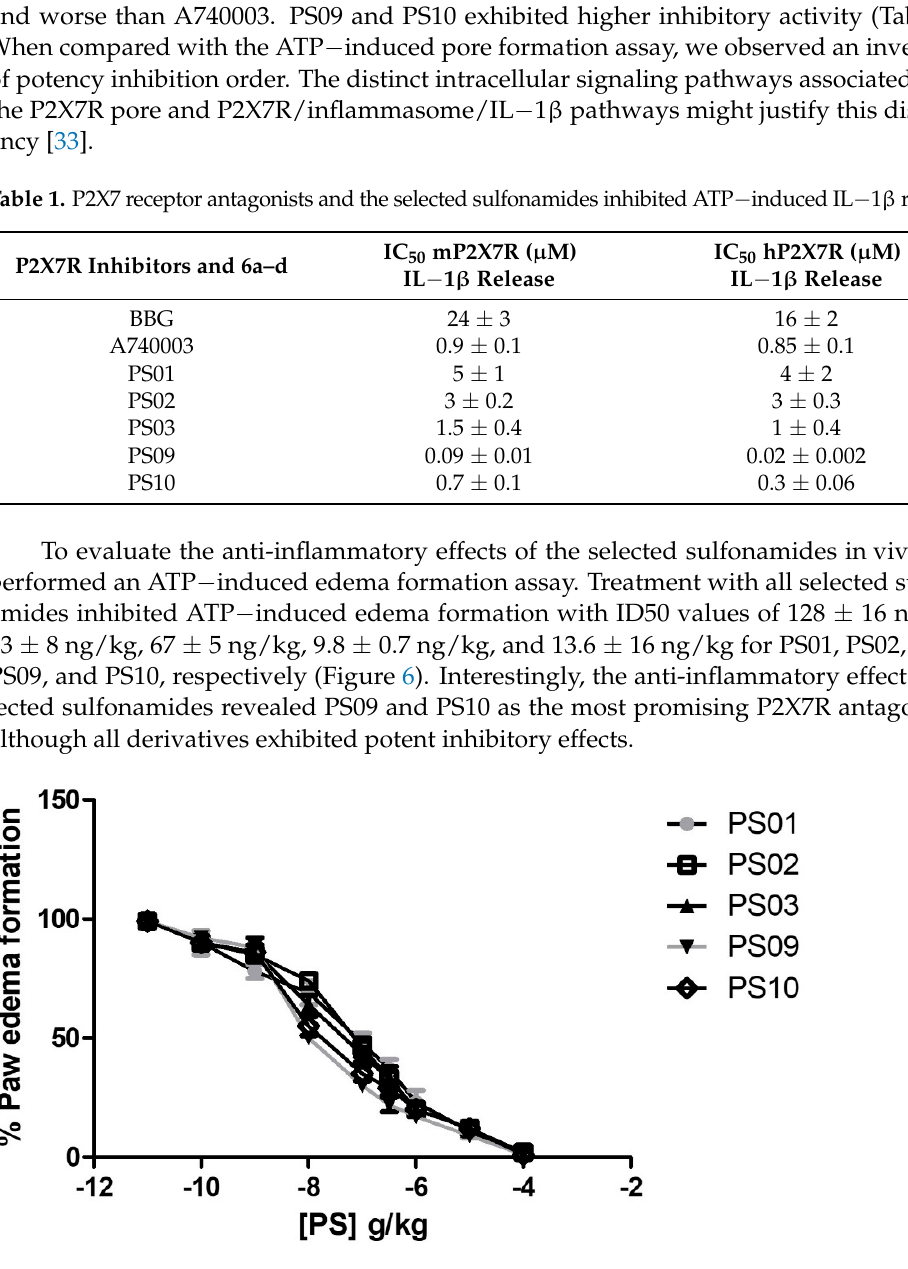
Figure 6. Anti − edematogenic effects of sulfonamides on ATP ‐ induced paw edema in mice. Groups with five Swiss Webster mice treated with ATP (intra ‐ plantar) were preincubated for 30 min with increasing doses of sulfonamides. All sulfonamide data were compared with crescent BBG doses (data not shown). Paw edema was measured at 30 min after ATP application. These results represent three distinct days with five animals for each group.